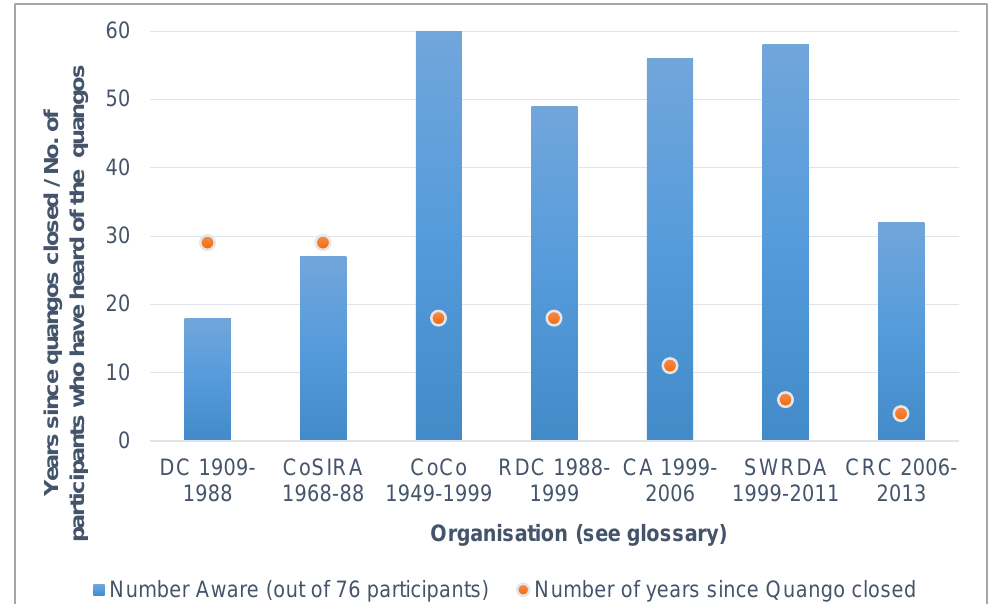
Figure 2: Participants’ awareness of existence of quangos, and years since quangos